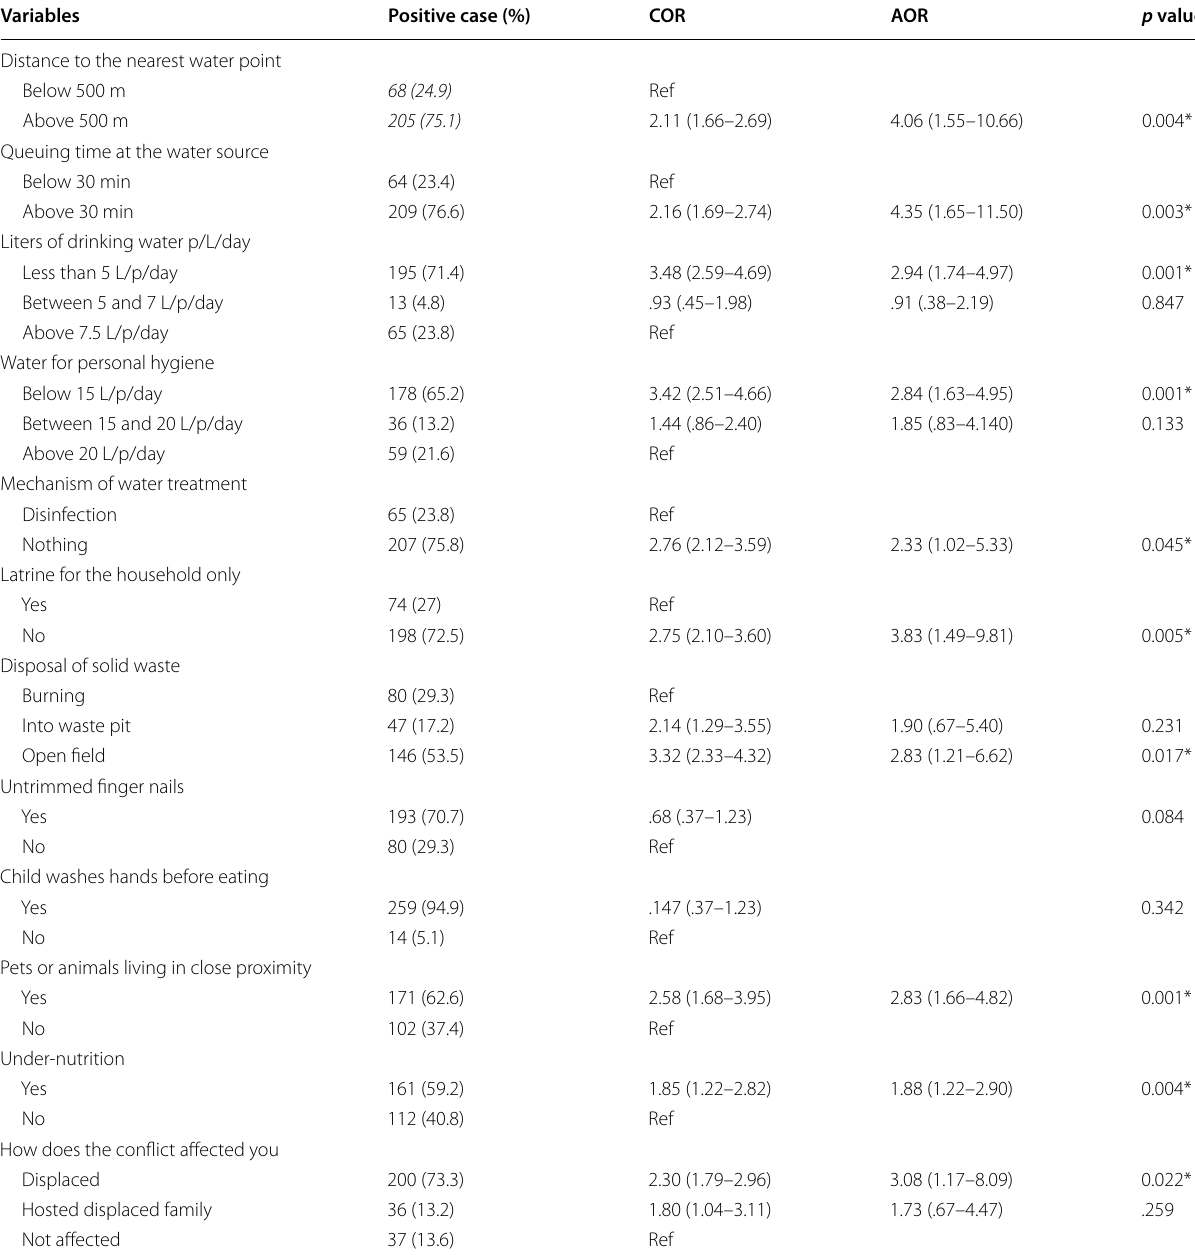
Table 6 Soil-transmitted helminthiasis and the associated risk factors among study participants, southern Ethiopia, 2021